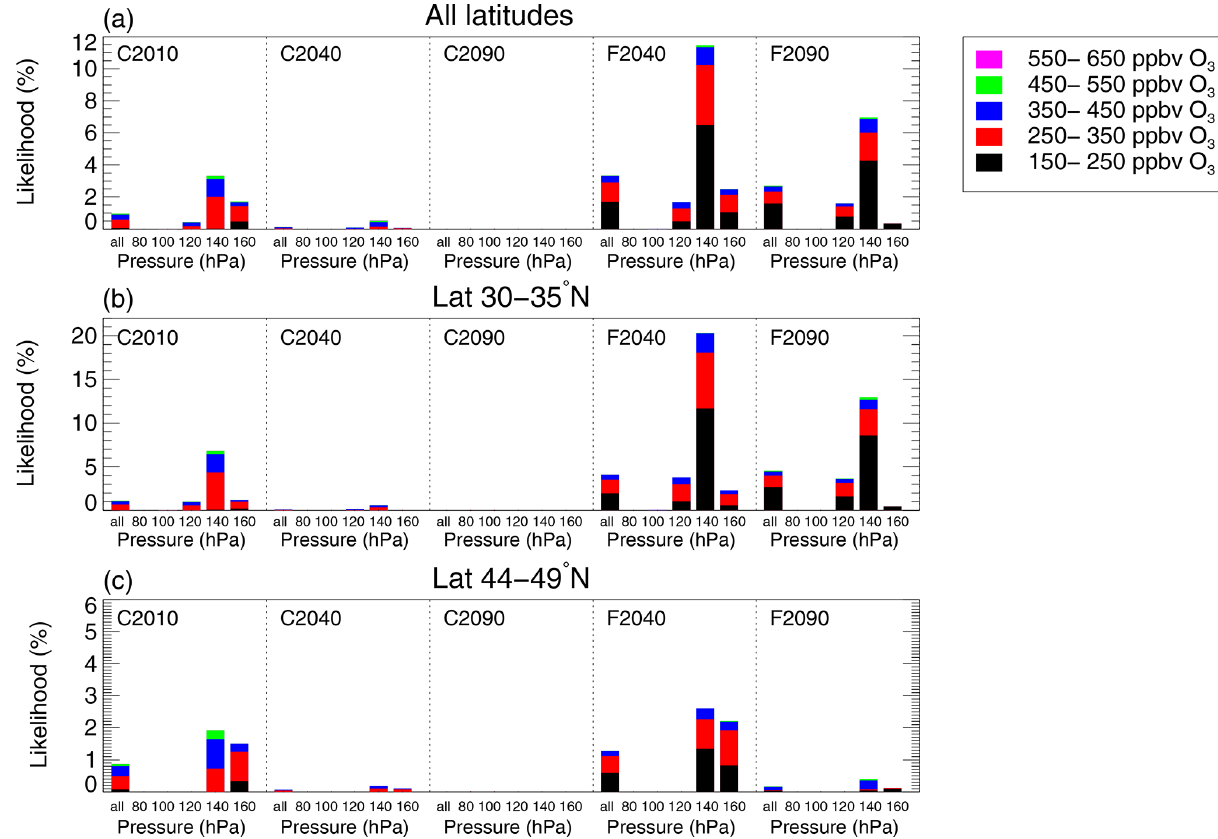
Figure 8. Likelihood of heterogeneous chlorine activation occurring in different latitude regions in the mixing layer for all considered cases of today and the future scenarios (see Table 1). The entire latitude range above central North America (30–49 ◦ N) is considered in (a) , only the subtropical latitude band (30–35 ◦ N) is considered in (b) , and only the extratropical latitude band (44–49 ◦ N) is considered in (c) . Different panels correspond to different cases given at the top of each panel. The height of the bars marks the likelihood of a specific pressure level given under that bar. The pressure range corresponding to a given pressure level is given in Table 2. The denotation “all” refers to the whole pressure range of the mixing layer. Colours indicate the likelihood of chlorine activation occurring for air masses with different ozone ranges. Note the different y axes for the three